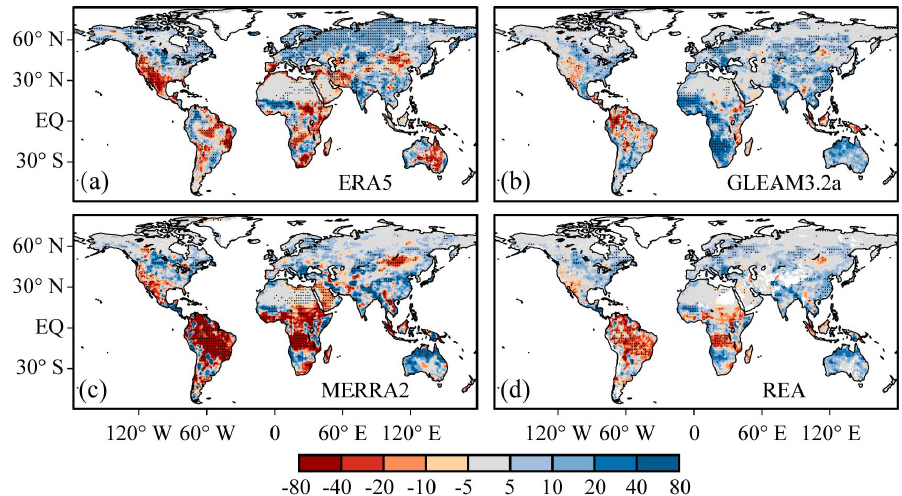
Figure 9. Spatial distribution of linear trends of land evaporation for the period 1980–2017 (unit: mm per decade). Stippling indicates statistically significant regions at a 95% confidence level of the Mann–Kendall